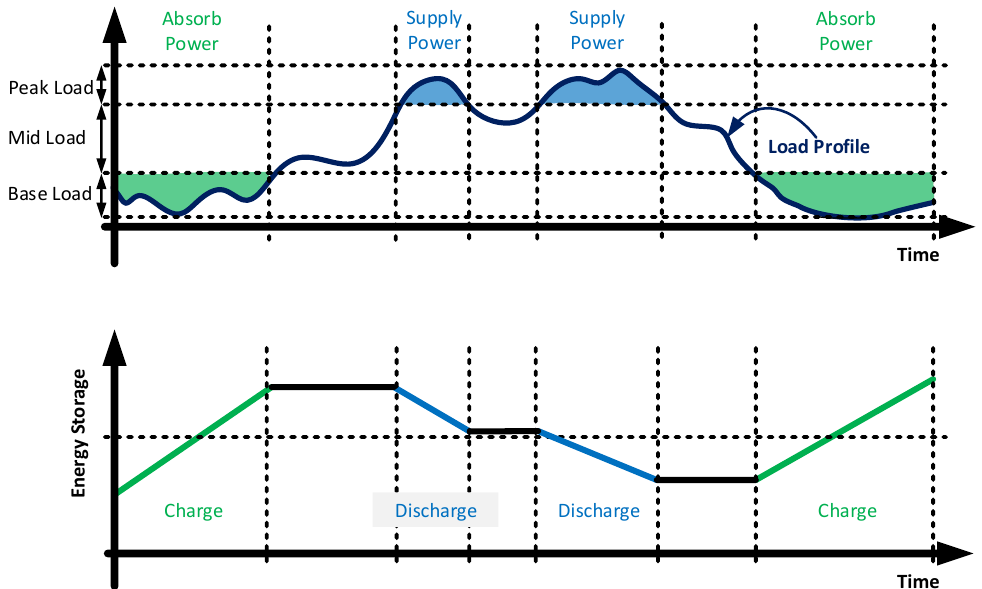
Figure 1. Illustrative example of storage based-peak